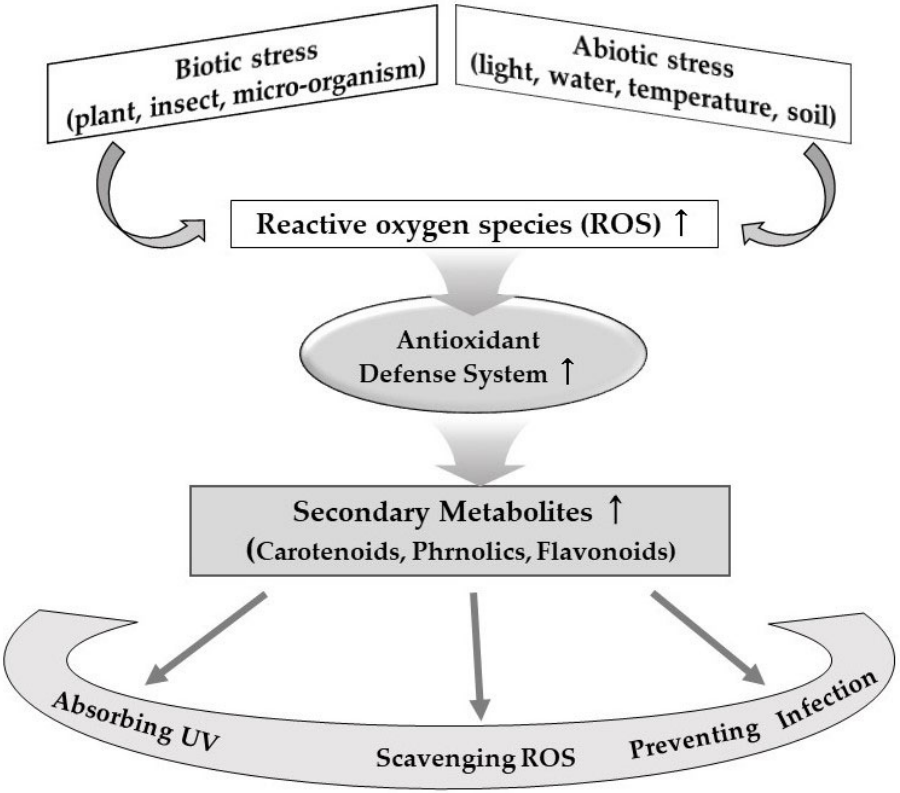
Figure 2. Schematic diagram of the mechanism of biological production of bioactive compounds in plant foods.